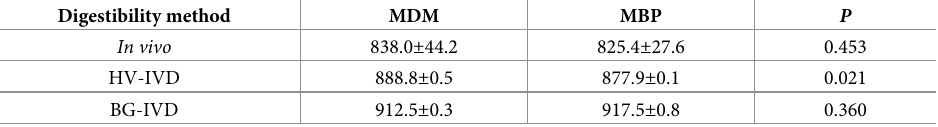
Table 10. In vitro dry matter digestibility (g/kg) according to the Hervera et al. method (HV-IVD), [38] and according to the Biagi et al. method (BG-IVD), [39] and in vivo dry matter digestibility ( in vivo ) of the two diets (MDM = Mechanically Deboned Chicken Meat diet and MBP = Meat By-Products diet) and the significance between them. Digestibility method